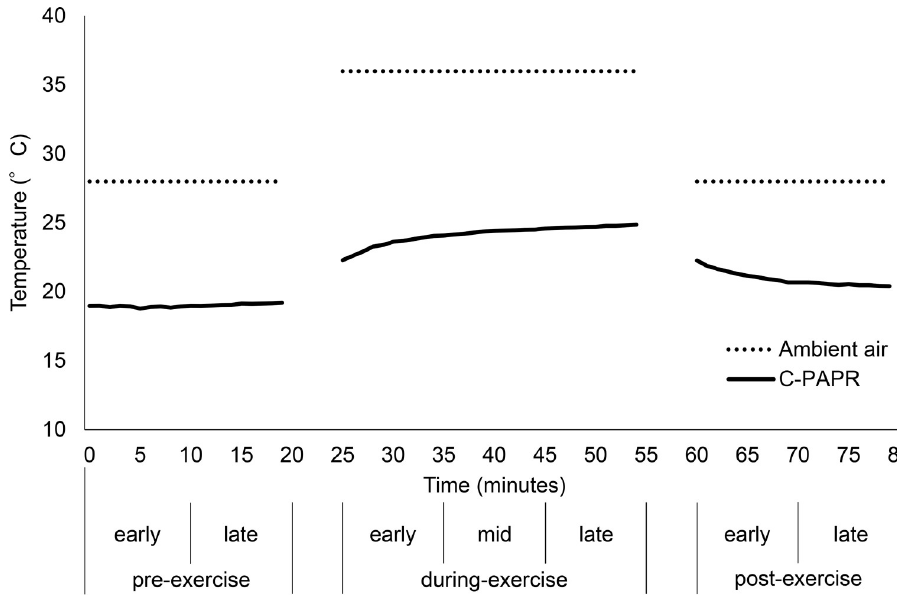
Fig 6. Inhalation temperature. The ambient air temperature and temperature near the powered air-purifying respirator inlet in the container of the cooling device were measured. The measured values of the time taken to move to the next room were excluded; C-PAPR: temperature near the powered air-purifying respirator inlet in the container of the cooling